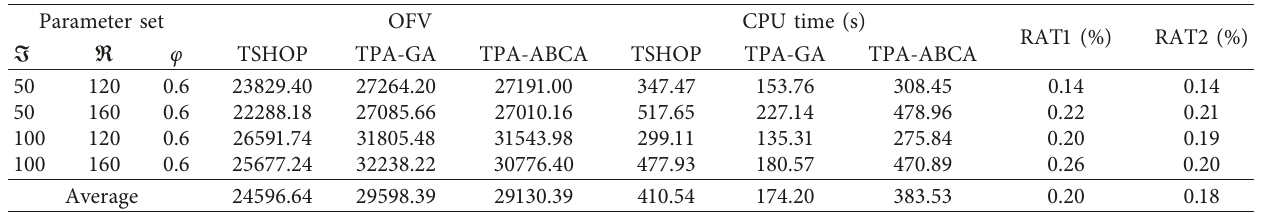
Table 8: Performance for TSHOP, TPA-GA, and TPA-ABCA applied to the instance with 24 item tasks. Parameter set OFV